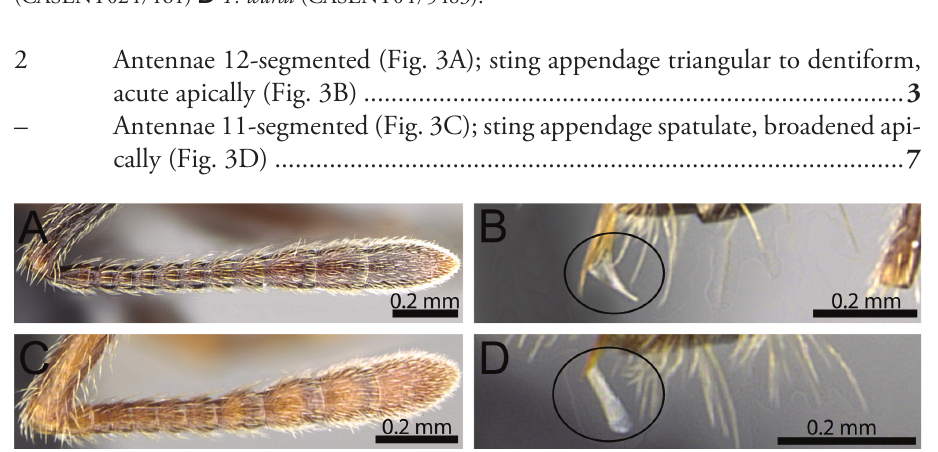
Figure 3. Antennal funiculus and sting appendage (within black ellipses). A, B T. tosii (CASENT0249662) C T. jedi (CASENT0043578) D T. hobbit